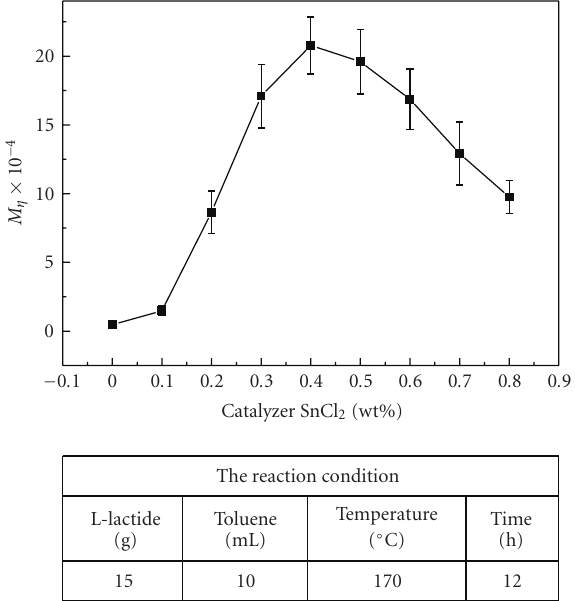
Figure 3: The relationship between the amount of catalyzer and M η of